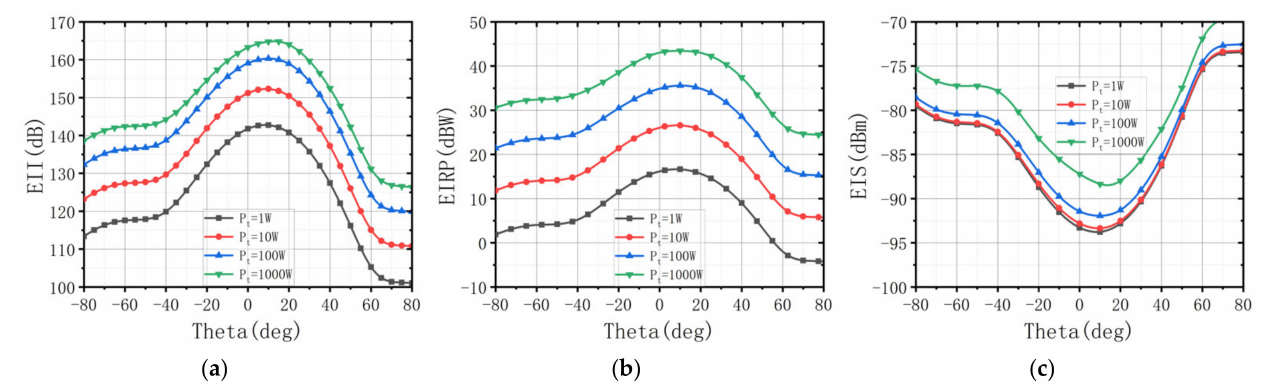
Figure 9. Transmit and receive beamforming vector.